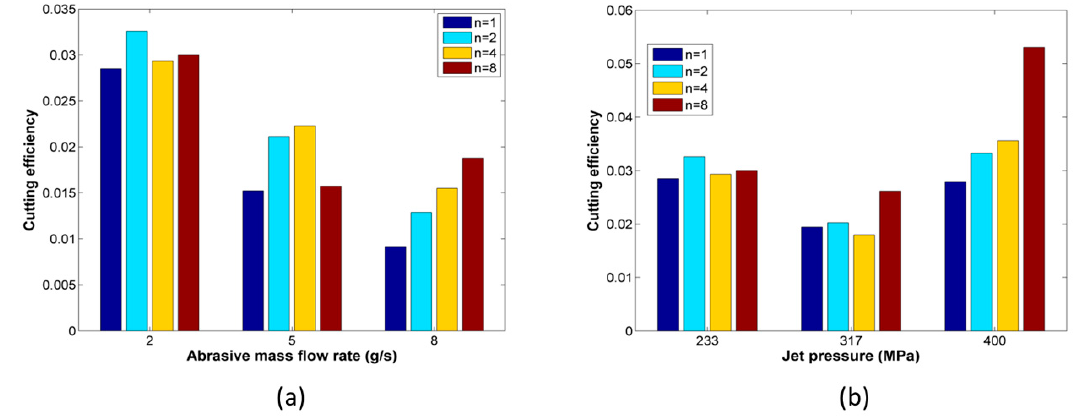
Figure 10. Variation of the cutting efficiency for increasing number of passes in respect to ( a ) abrasive mass flow rate and ( b ) jet pressure.